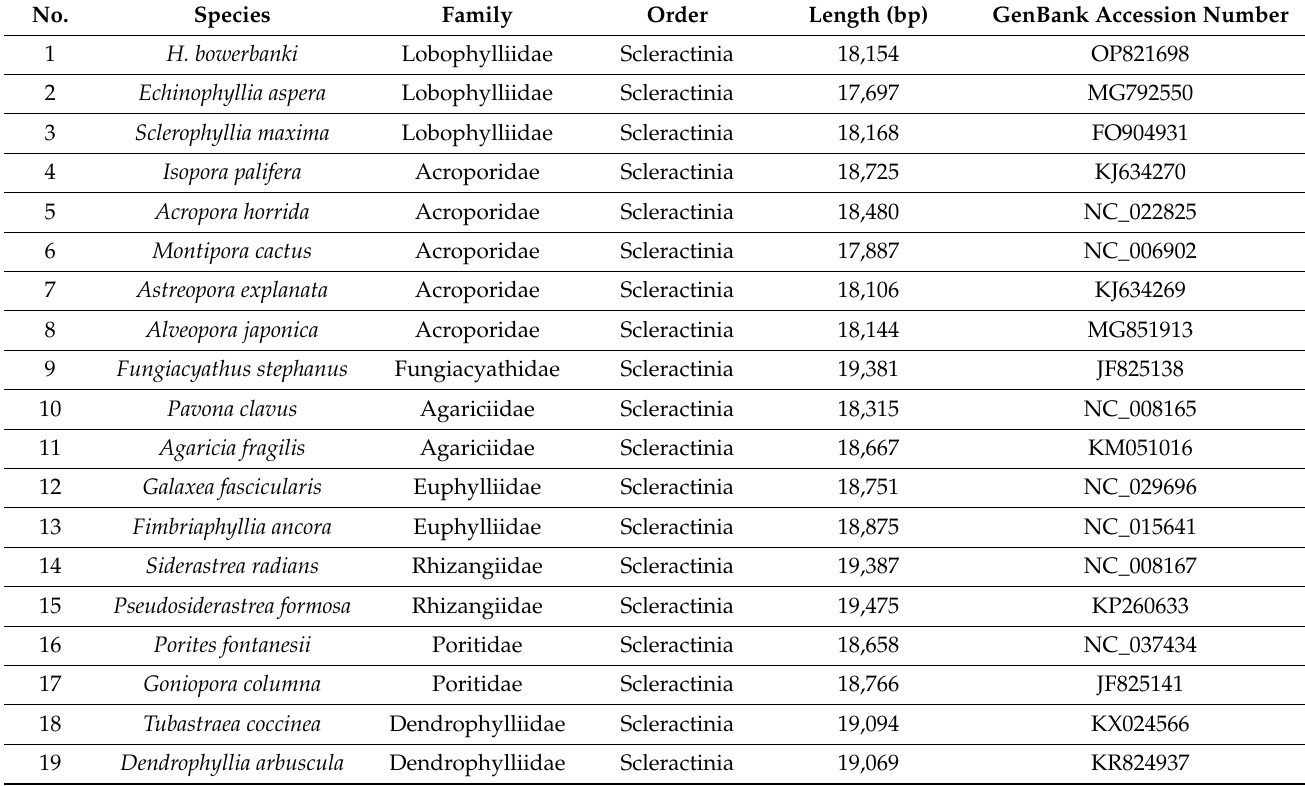
Table 1. Representative Scleractinians and the outgroup species of Corallimorpharia used in the maximum likelihood phylogenetic